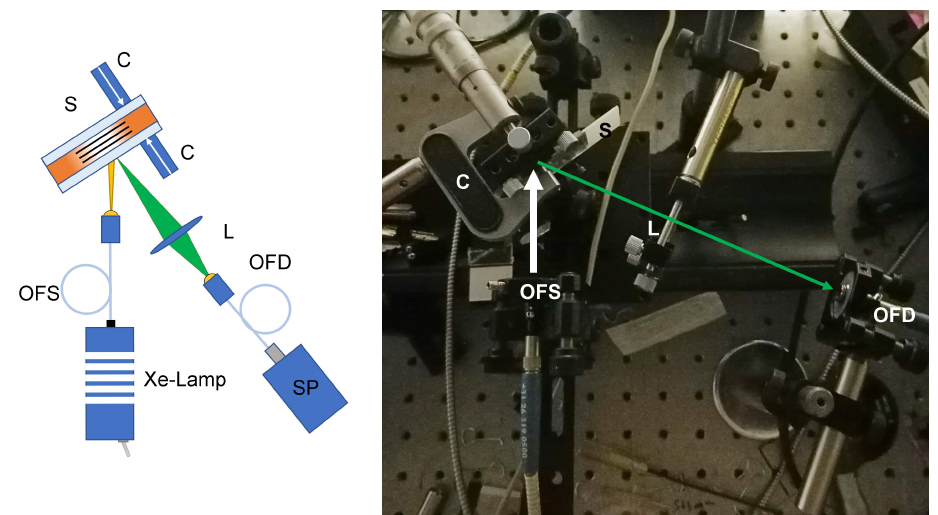
Figure 3. Reading setup. OFS: optical fiber (light) source; S: sample; C: clamping system; L: lens; OFD: optical fiber (light) detector; SP: Spectrometer. Shown on the right side is the real experimental